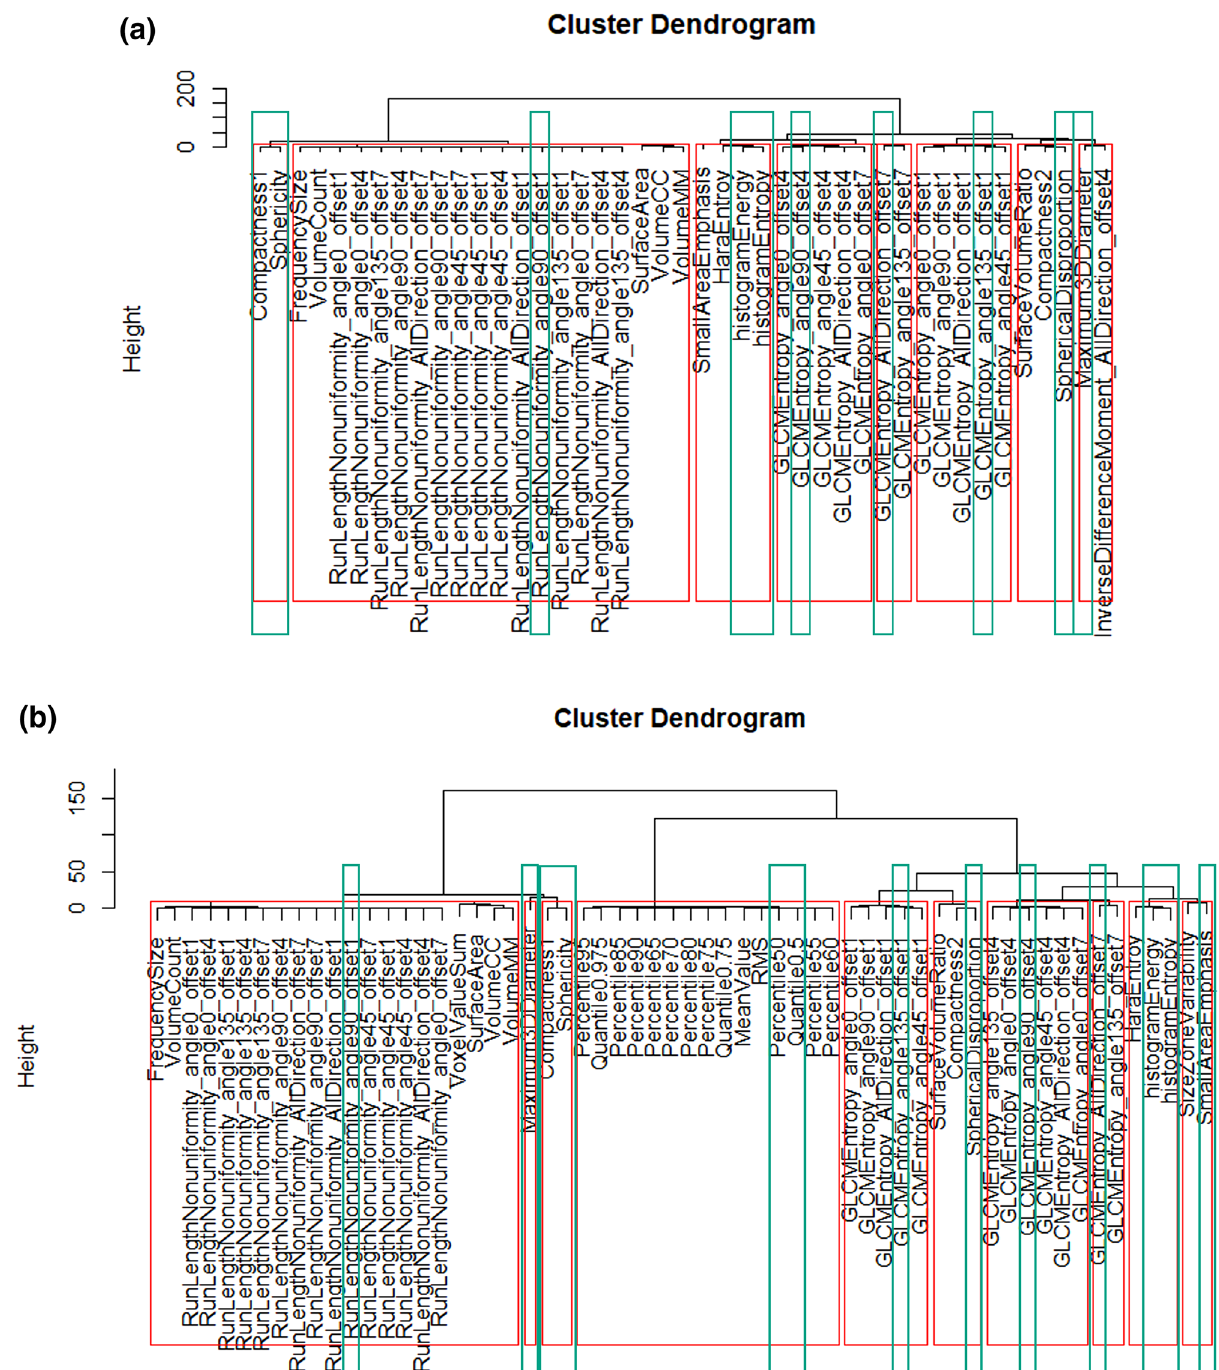
Figure 1. Hierarchical cluster analysis. Note Cluster dendrograms without intensity normalization ( a ) and with intensity normalization ( b ). The red frames represent different groups and within them the green frames highlight the representative features selected